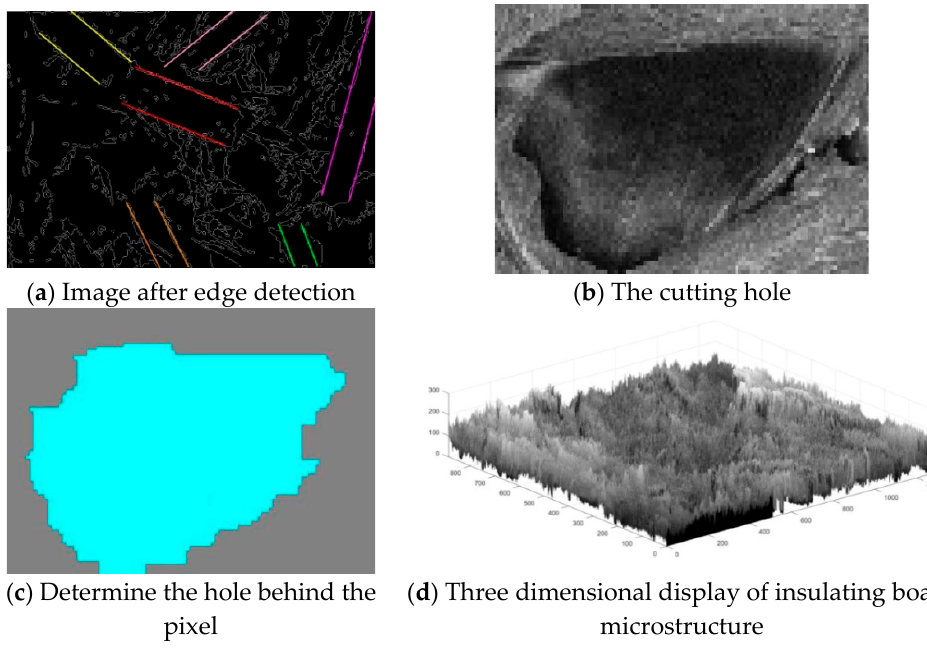
Figure 4. The displays of measurement